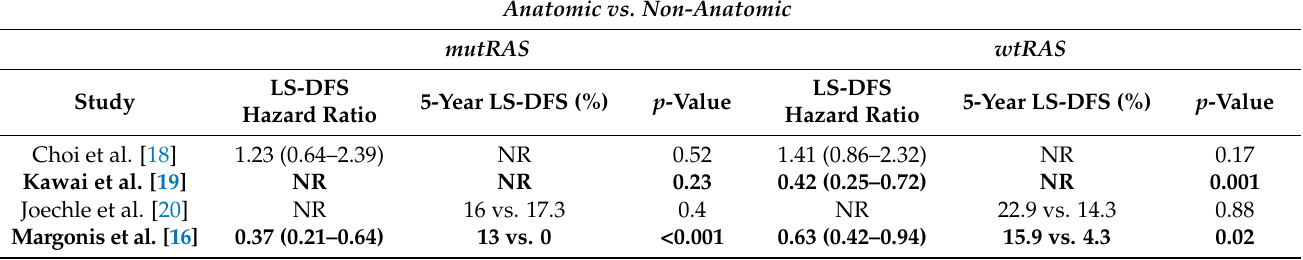
Table 2. Survival outcomes in anatomical versus non-anatomical liver resections depending on RAS mutational